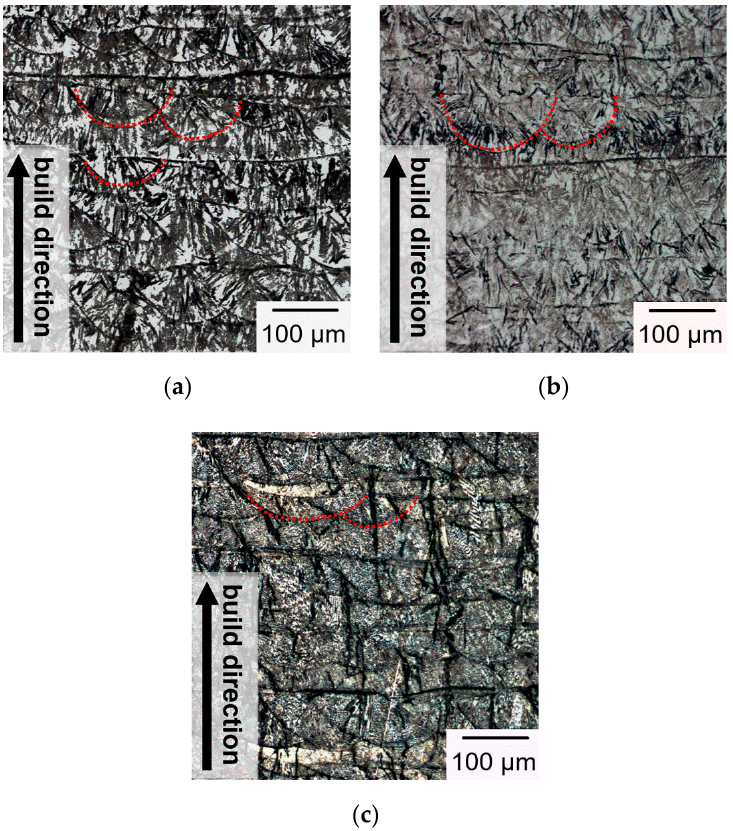
Figure 11. Optical microscopy (OM) micrographs of representative microstructure in the SLM Figure11. Opticalmicroscopy(OM)micrographsofrepresentativemicrostructureintheSLMspecimens: specimens: ( a ) Group A; ( b ) Group B; ( c ) Group C. (Arrow indicates the build direction.). ( a ) Group A; ( b ) Group B; ( c ) Group C. (Arrow indicates the build